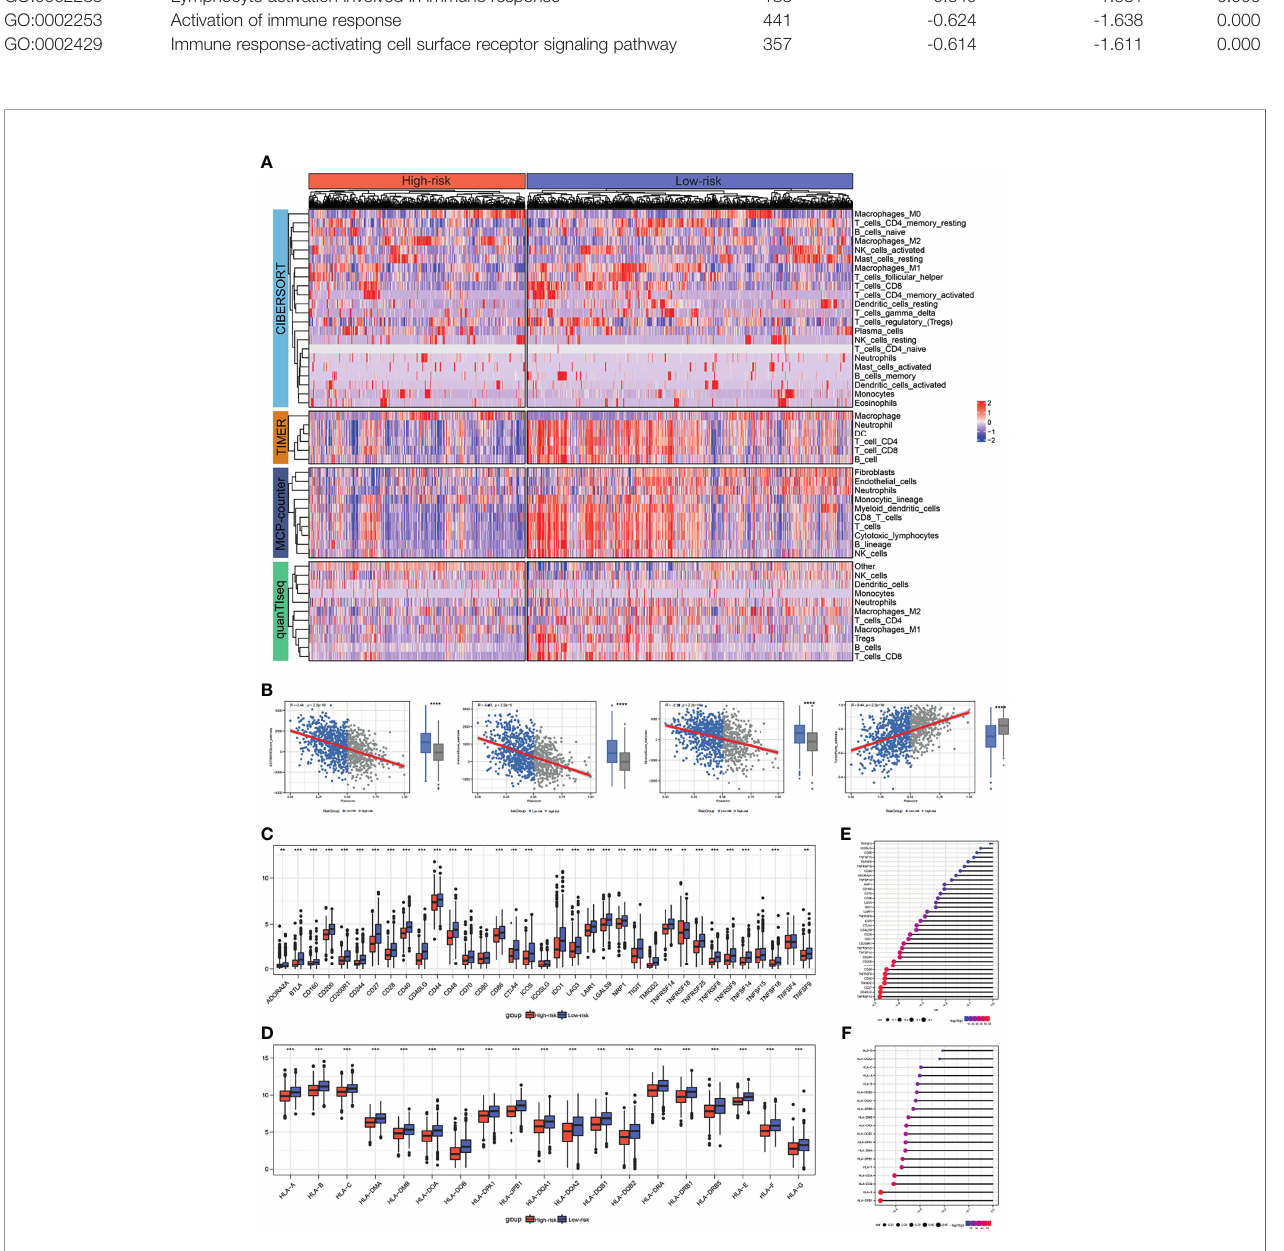
FIGURE 4 | The correlation between risk score and expression of the immune checkpoints/HLA family genes. (A) Landscape of immune and stromal cell in fi ltrations in the low- and high-risk patients. (B) Association between estimate score, immune score, stromal score, tumor purity, and risk score and their distribution in the low- and high-risk groups. (C) Analyses for the expression of immune checkpoints genes in different groups. (D) Analyses for the expression of HLA family genes in different groups. (E) Correlation analysis for risk score and expression of immune checkpoints. (F) Correlation analysis for risk score and expression of HLA family genes. * P < 0.05; ** P < 0.01; *** P < 0.001; ns, not signi fi cant.